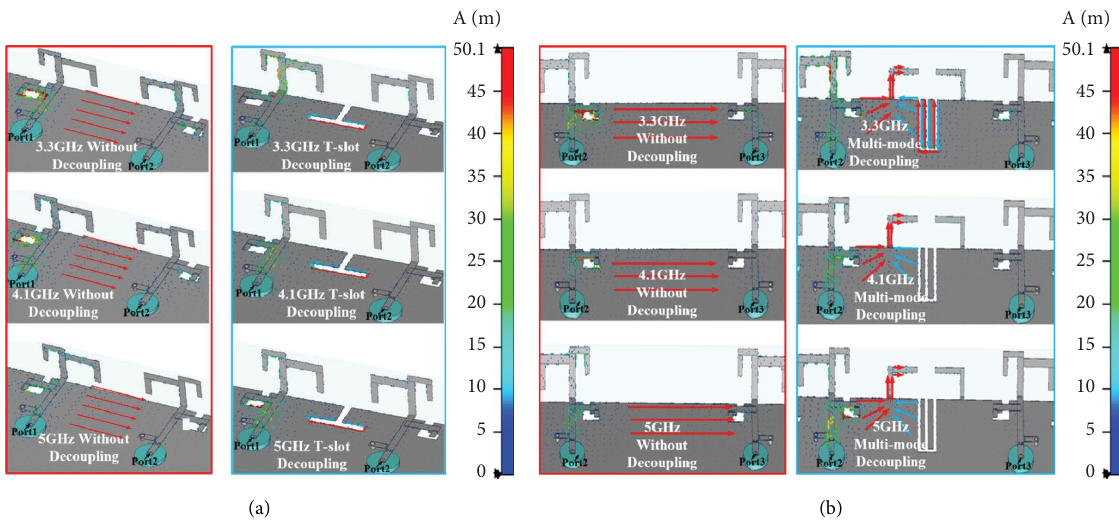
Figure 8: Current distribution in the vicinity of two ports with or without: (a) T-slot decoupling structures and (b) quasi-M slot combining parasitic strips decoupling structures.